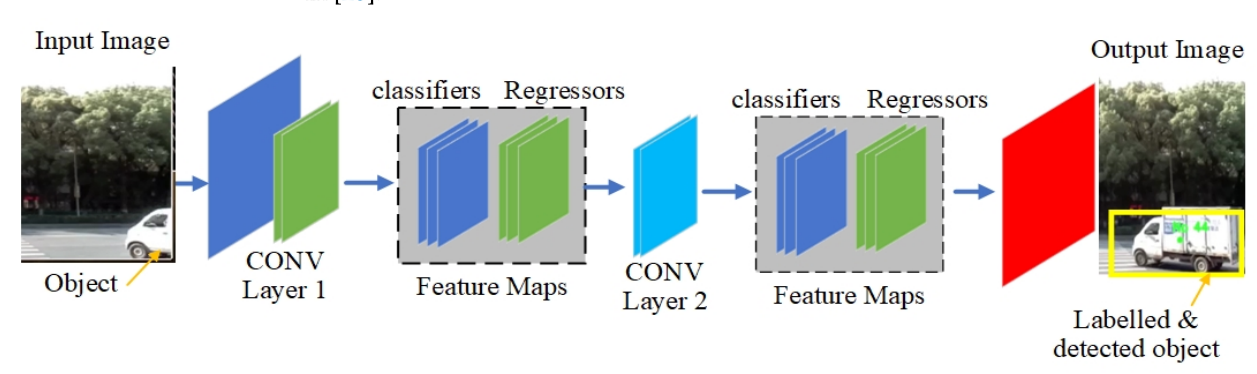
Figure 2. The single shot multi-box detector mobile net (SSD-mobile net) model structure.